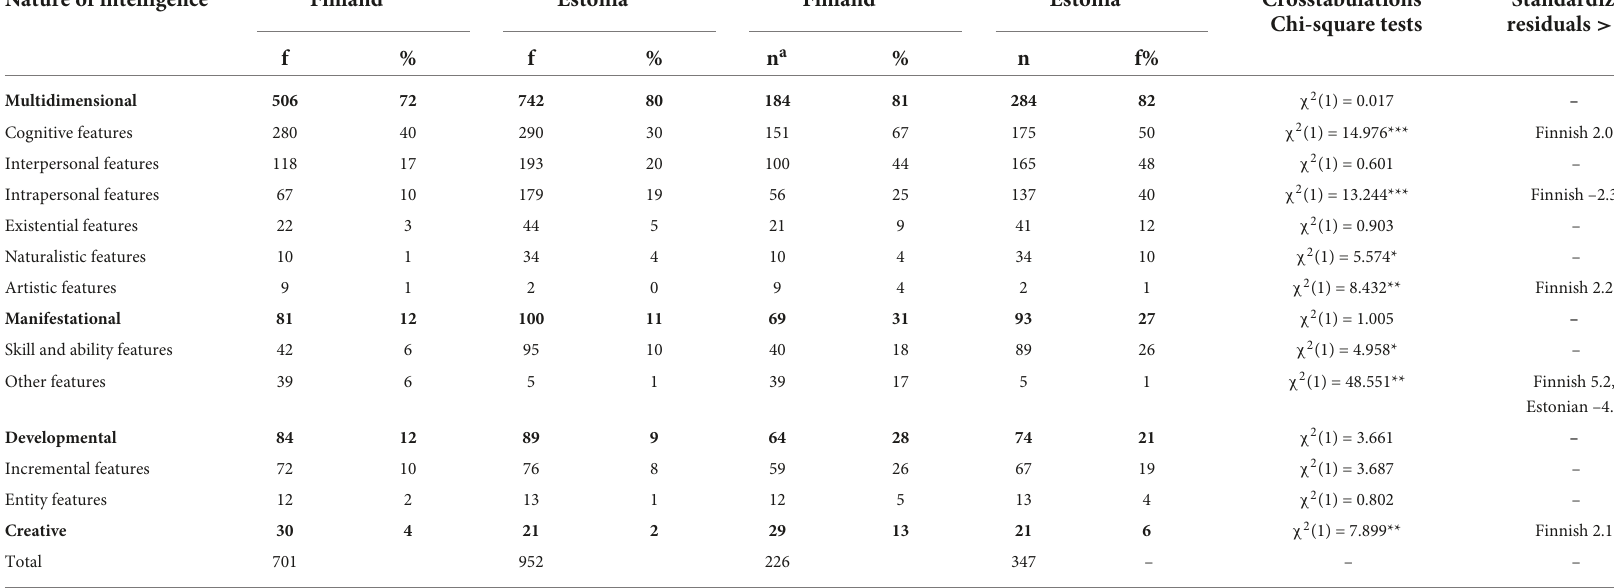
TABLE 3 Teachers’ views on the nature of intelligence in the qualitative data. Nature of